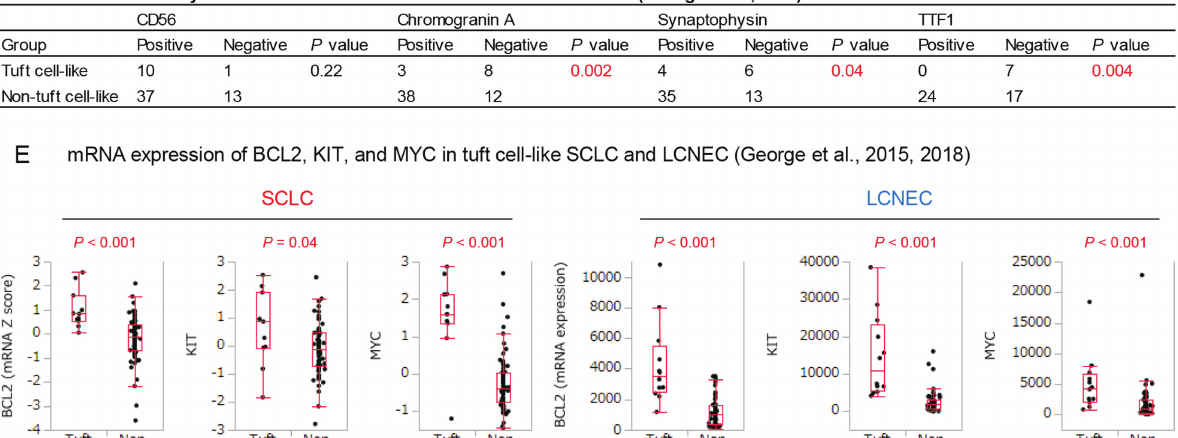
Fig. 3 Expression pro fi les of tuft cell-like lung cancers. Transcriptional and immunohistochemical features of tuft cell-like lung cancers retrieved from public datasets ( A , B , E [24]. A , C , D , E [27]) (FPKM, fragments per kilobase of exon per million reads